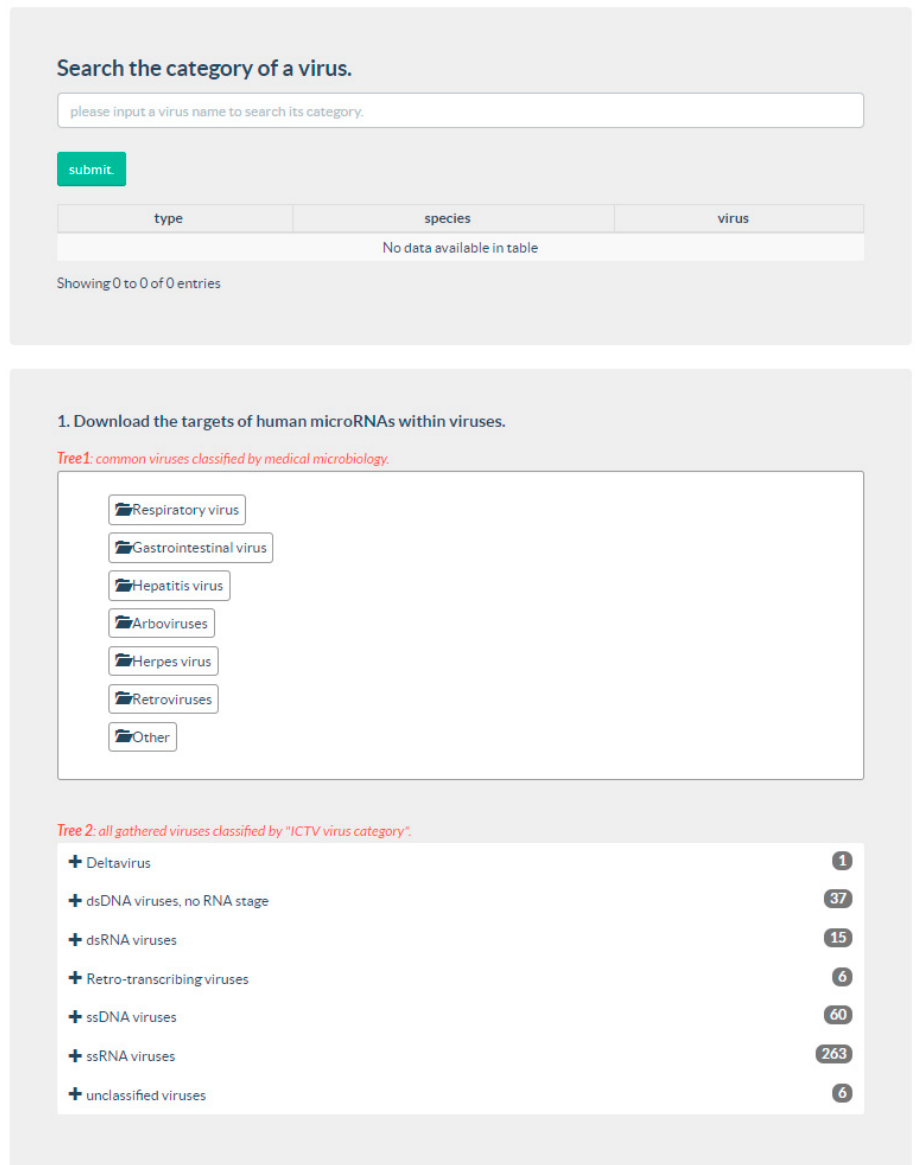
Figure 2. The interface of mirTar database.